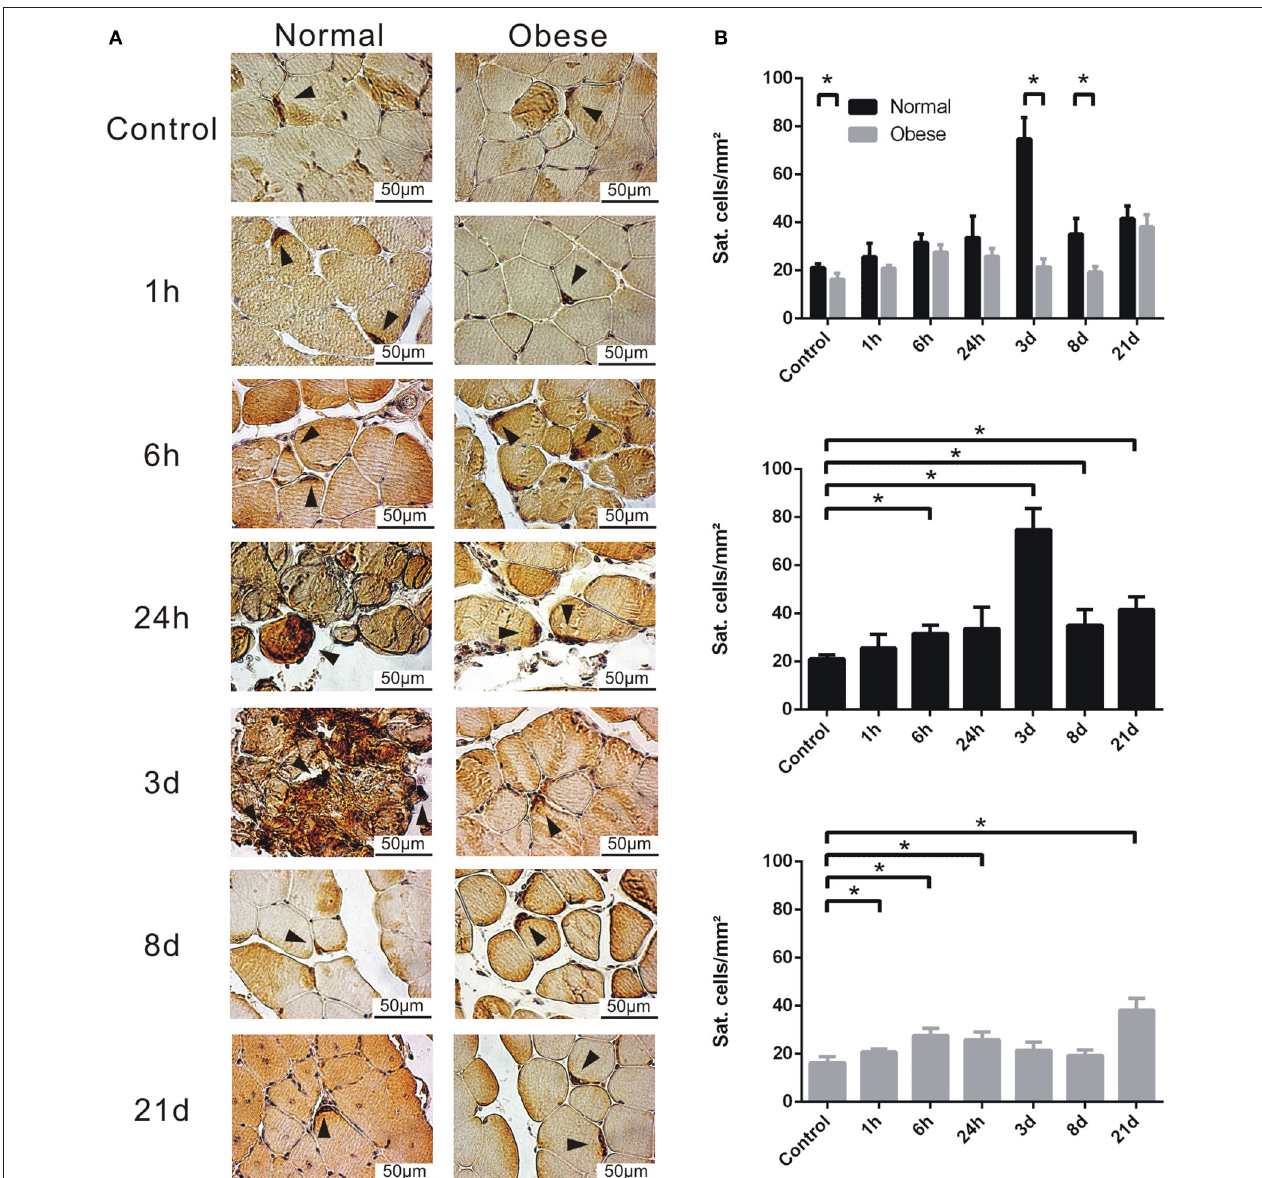
FIGURE 8 | Determination of Pax7-positive satellite cells by IHC. (A) Tissue sections of female normal weight and obese C57BL/6J mice, labeled with anti-Pax7, and stained with DAB. Triangle = satellite cell. Pictures were taken with Olympus IX81 using Xcellence v.1.2. Scale = 50 µ m at 40x magnification. (B) Calculated satellite cells per mm 2 . Six animals per time point à three sections per animal were independently counted by three researchers, averaged and depicted. Black = normal weight; Gray = obese. Statistical analysis by homoscedastic two-sided t -test. *Indicates p ≤